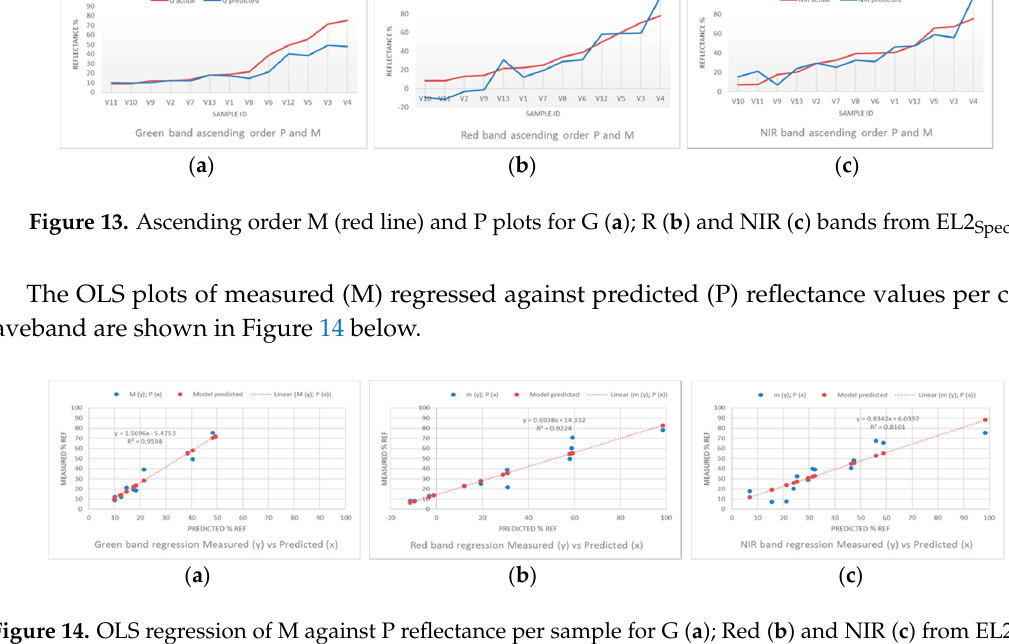
Figure 12. M (red line) and P reflectance plots for G ( a ); R ( b ) and NIR ( c ) bands from EL2 Spect .